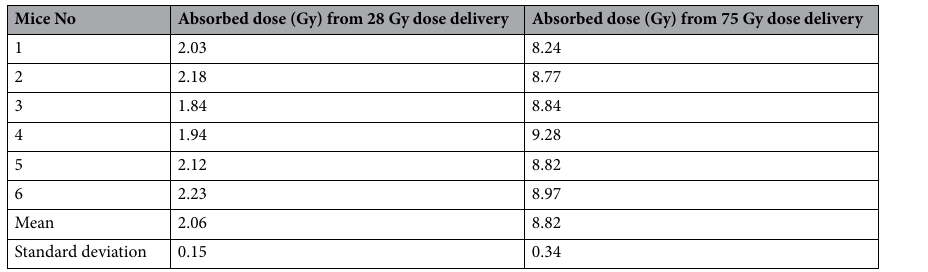
Table 2. The absorbed dose from 28 and 75 Gy delivery